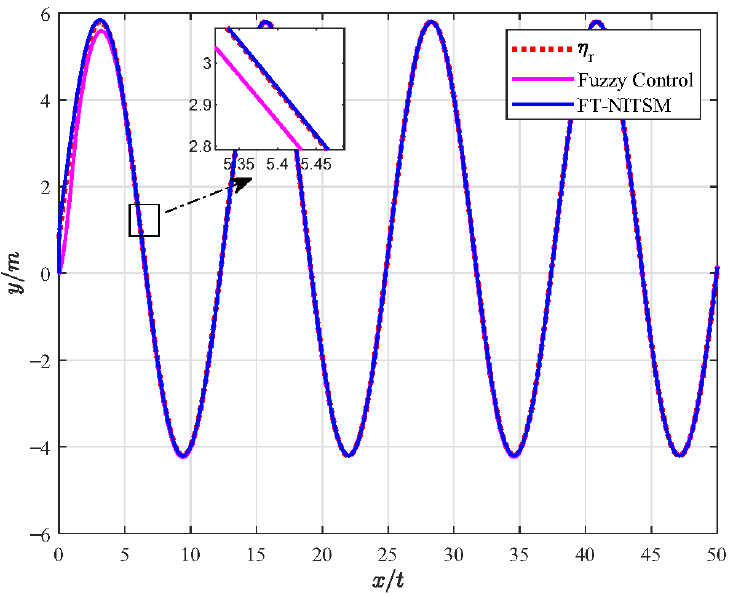
Figure 6. The error diagram of FT-NITSM tracking control and adaptive control.